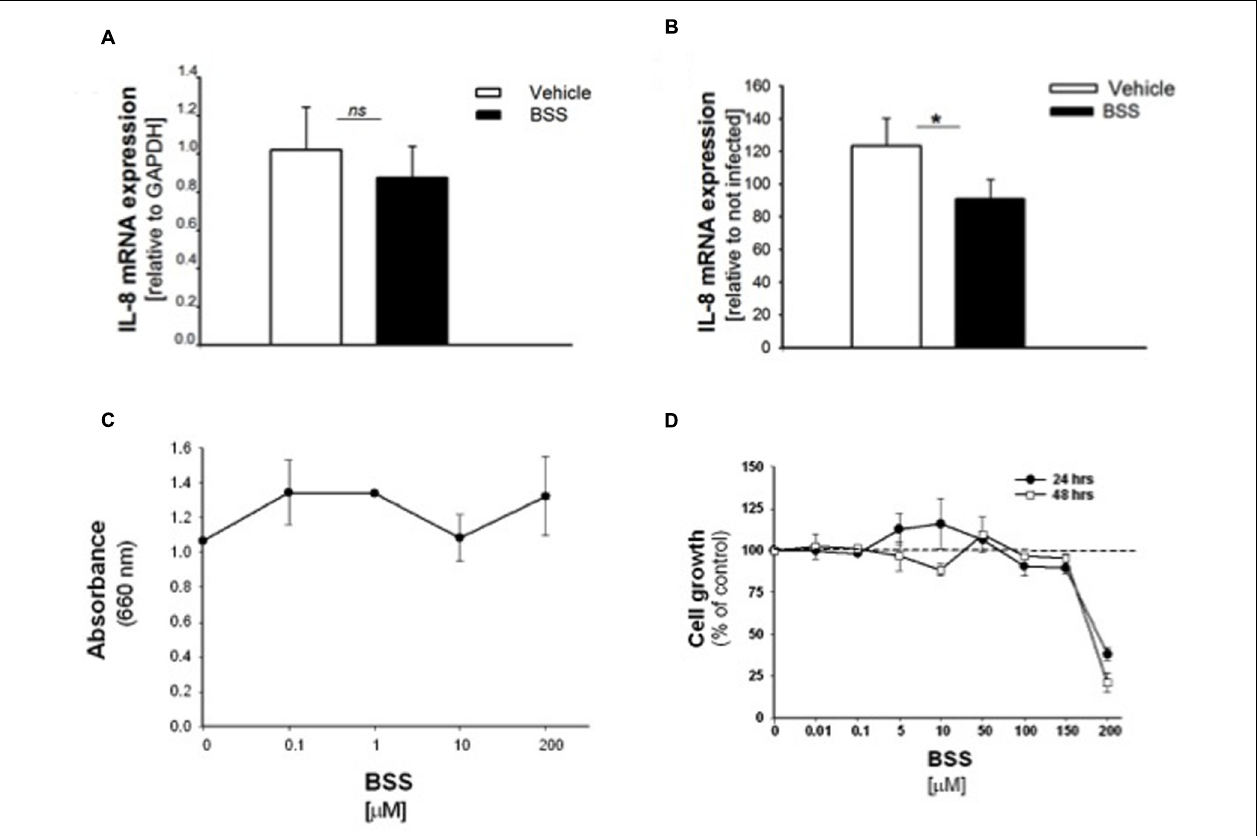
FIGURE 5 | Effect of BSS on IL-8 mRNA, bacterial growth and cell viability in CuFi-1 cells. Cells were treated for 16 h with BSS (100 nM) and infected with PAO1 for further 4 h. IL-8 mRNA expression was measured as indicated in the legend of Figure 2 . (A) Basal IL-8 mRNA expression. Data are expressed as relative to the expression of GAPDH housekeeping gene. (B) PAO1-stimulated mRNA expression. Data are expressed as relative to not infected cells. (C) PAO1 growth. Bacteria were cultured overnight at 37 ◦ C in the presence of solvent or ranging doses (0.1– 200 µ M) of BSS. Bacterial growth was monitored by absorbance measures at 660 nm. A representative experiment performed in duplicate is shown. (D) Cell viability. CuFi-1 cells were treated with solvent alone or BSS (0.01–200 µ M) for 24 and 48 h. Cell viability was recorded by cytometer analysis. Data are expressed as % control (solvent) and are relative to a representative experiment performed in duplicate. Dashed line corresponds to cells treated with solvent